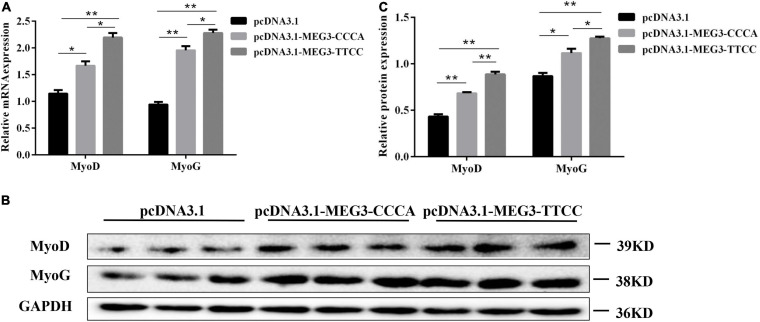
MEG3 haplotypes overexpression promoted differentiation in SCs. (A) The mRNA expression of differentiation-related genes in pcDNA 3.1 (+), pcDNA3.1-MEG3-CCCA, or pcDNA3.1-MEG3-TTCC groups by qRT-PCR analysis. (B,C) Western blot assay was performed to examine differentiation-related protein expression in pcDNA 3.1 (+), pcDNA3.1-MEG3-CCCA, or pcDNA3.1-MEG3-TTCC groups. The significance test: *P < 0.05, **P < 0.01.